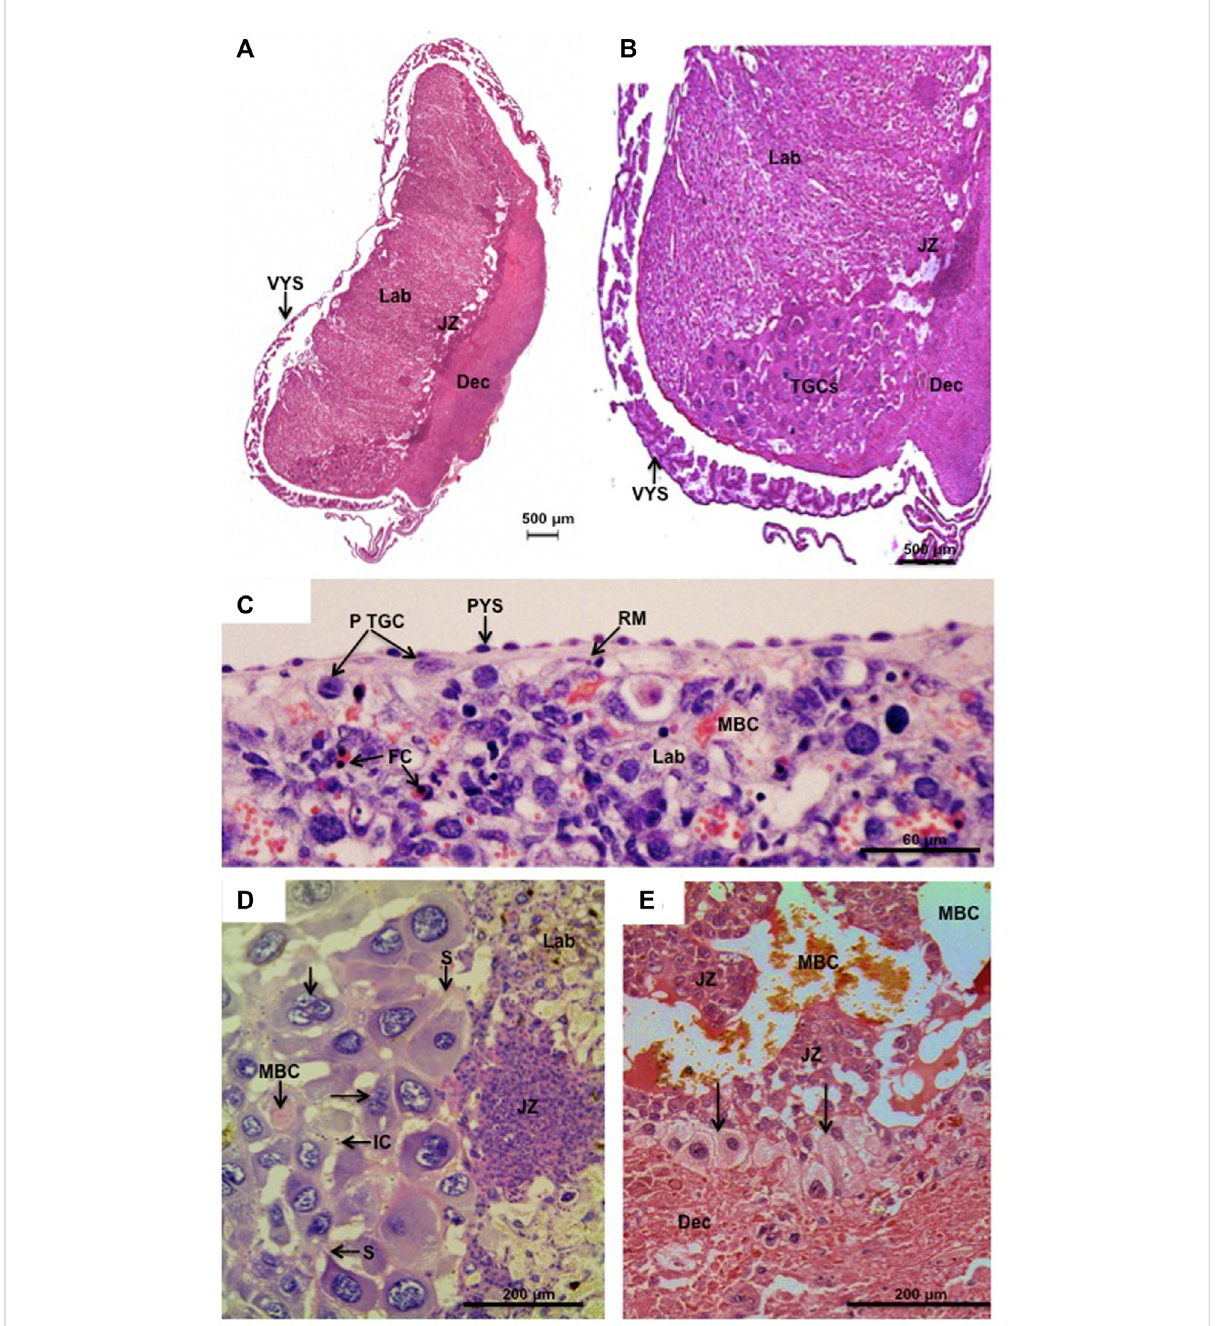
FIGURE 1 Parietal trophoblast giant cells (p-TGCs). (A,B) Hylaeamys megacephalus. Histology of the chorioallantoic placenta with the main compartments: labyrinth (Lab), junctional zone (JZ), and decidua (Dec). Note in (B) the trophoblast giant cells (TGCs) at the border of the junctional zone (JZ) and decidua (Dec). Visceral yolk sac (VYS) is close to the placental disk. Haematoxylin and eosin. (C) . Necromys lasiurus . p-TGCs near the surface of the placenta beneath Reichert ’ s membrane (RM) and parietal yolk sac endoderm (PYS). Lab = labyrinth, MBC = maternal blood channel, FC = fetal capillaries. Haematoxylin and eosin. (D) Hylaeamys megacephalus. Highly developed p-TGCs are closely associated with maternal blood channels (MBC). Note some bi- and tri-nucleated cells (arrows) and thesprouts (S) that maintaincontact betweentheparietal TGCs. IC = in fl ammatory cells, JZ = junctional zone, and Lab = labyrinth. Periodic acid-Schiff. (E) Cerradomys sub fl avus . p-TGCs (arrows) at the border of the junctional zone (JZ) and underlying the decidua (Dec). MBC = maternal blood spaces.